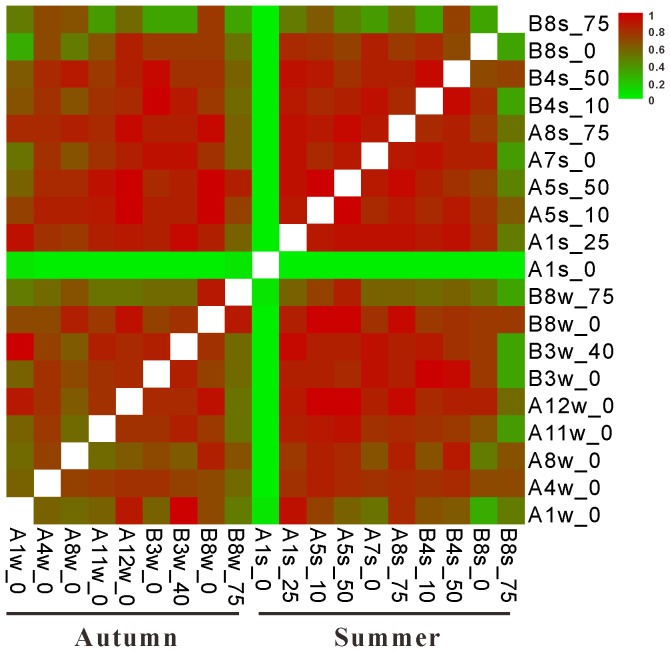
Proportion of shared OTUs based on abundance-based Sørensen-type (Labd) similarity between different thaumarchaeal accA clone libraries.OTUs clustered at a cutoff of 95% identity level.